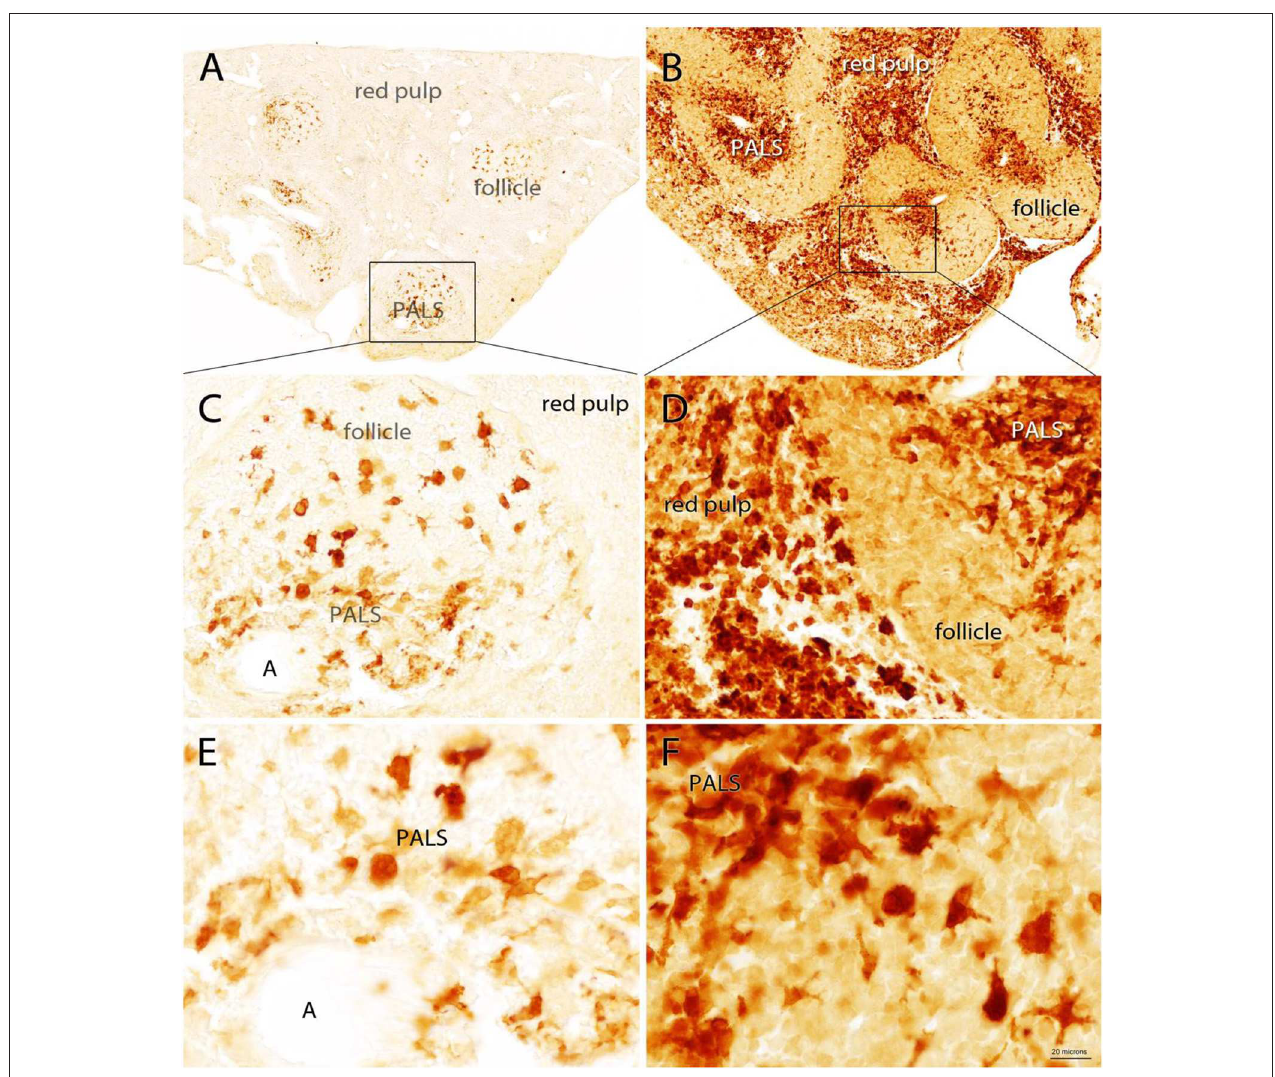
FIGURE 3 | Quin-IR in the gerbil spleen 24h after IP injection of saline (A,C,E) or PWM (B,D,F) . Quin-IR was low in the saline group, with most stained cells being present in the periarteriolar lymphoid sheaths (PALS) where antigen presentation occurs between dendritic cells and T cells. Cells in the red pulp were unstained or very lightly stained. In contrast, after PWM administration, Quin-IR was dramatically increased in both the red pulp and PALS. The core of the PALS was strongly stained, suggesting that the Quin-IR cells were dendritic cells. Intense Quin-IR was observed in the red pulp of PWM stimulated gerbils. A in panels (C,E) —arteriole. Bar in (F) , 200 µ m in (A,B) , 40 µ m in (C,D) , and 20 µ m in (E,F)